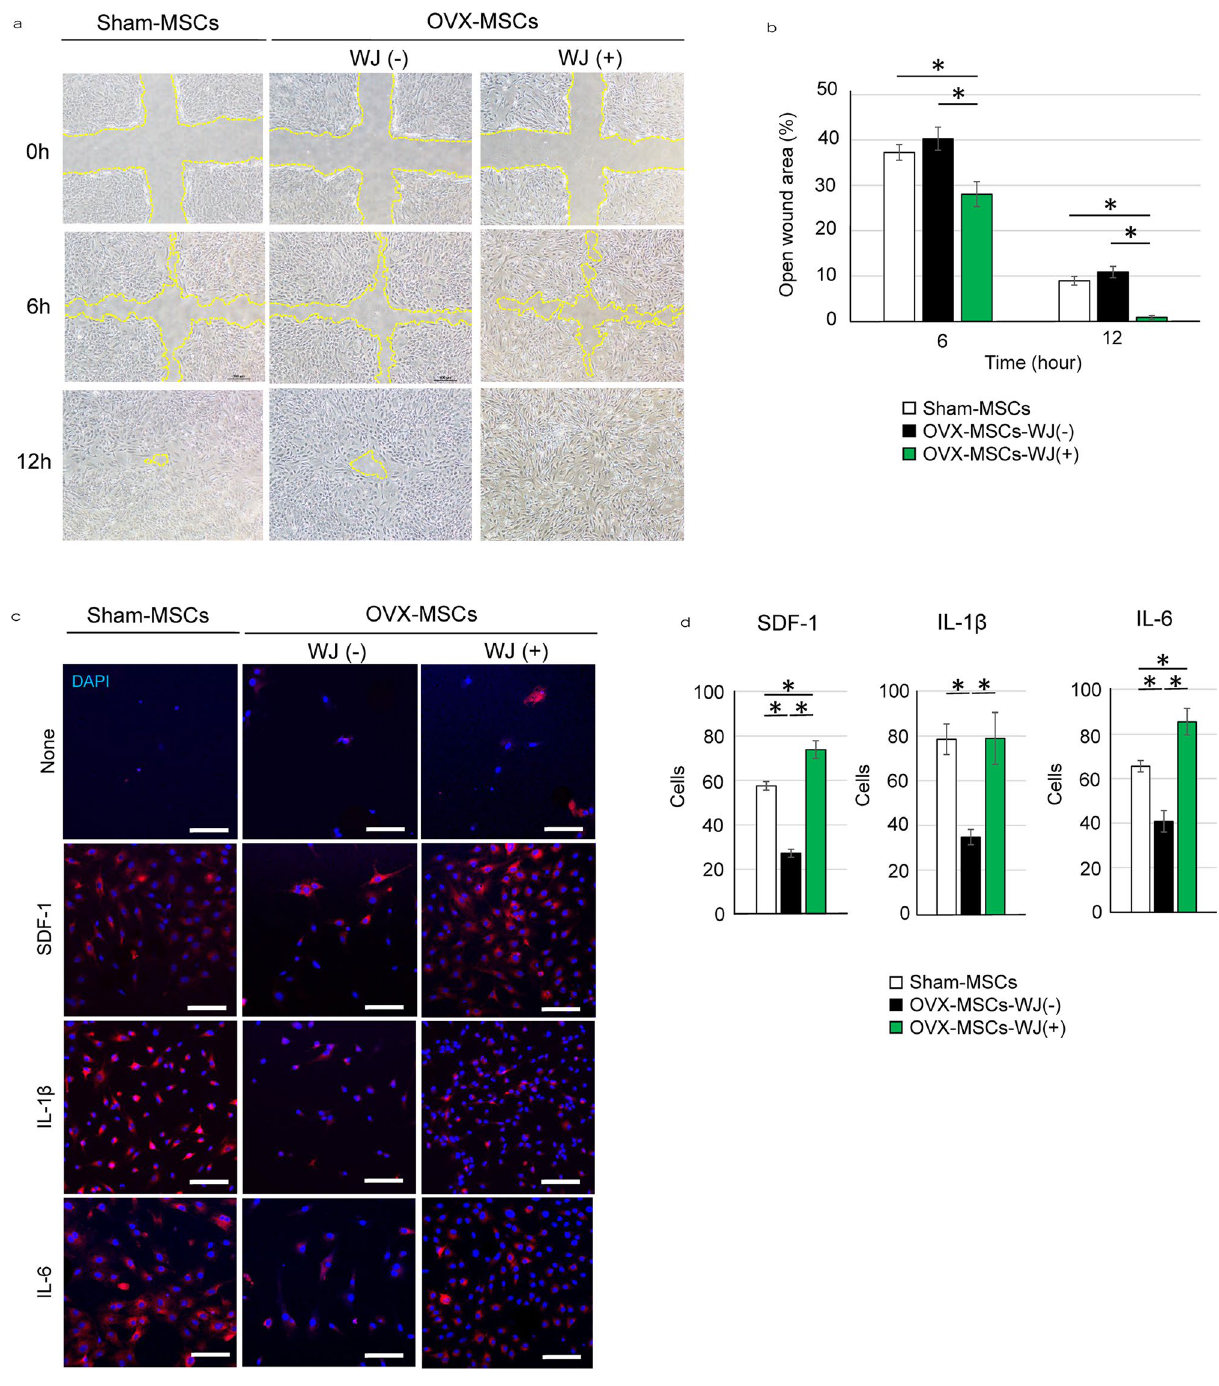
Figure 1. The correct version of Figure